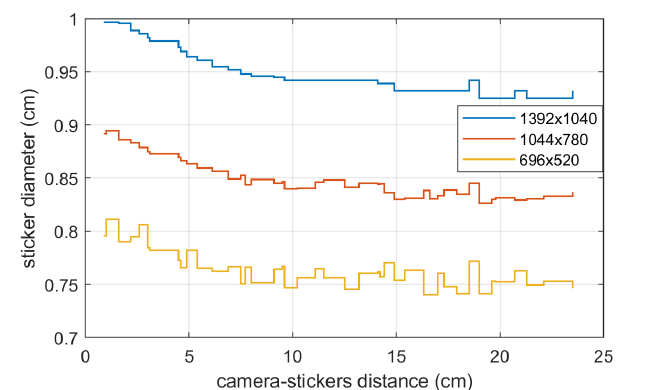
Figure 7. Variation in estimation of sticker diameter under different camera